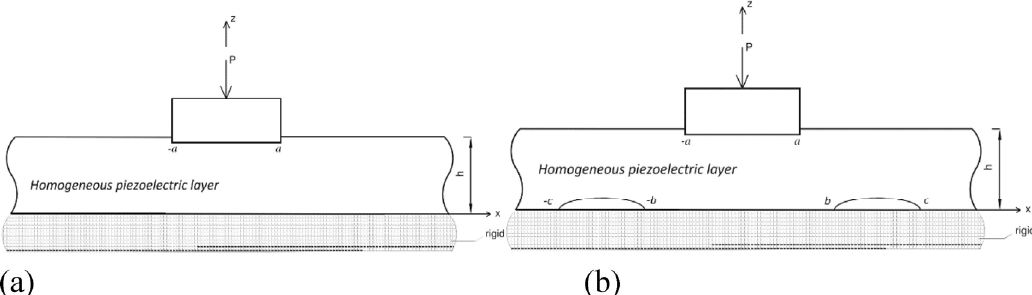
Fig. 69 Geometry of the (a) continuous contact problem and (b) discontinuous contact problem [898]. Reproduced with permission from Ref. [900], © Springer-Verlag GmbH Austria, part of Springer Nature,